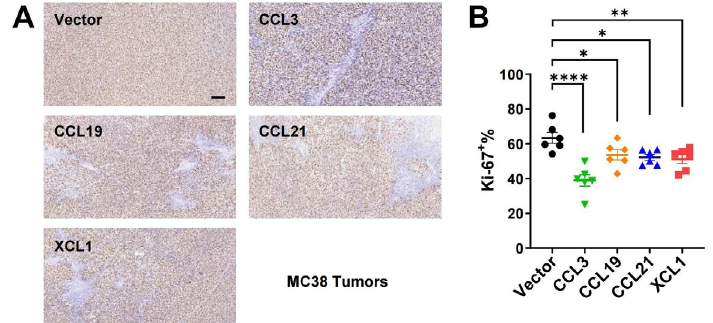
Figure 4. Immunohistochemistry for Ki-67 in MC38 tumors. A. Representative images of Ki-67 staining, scale bar = 50 μm; B. statistics of Ki-67 + ratios ( n =